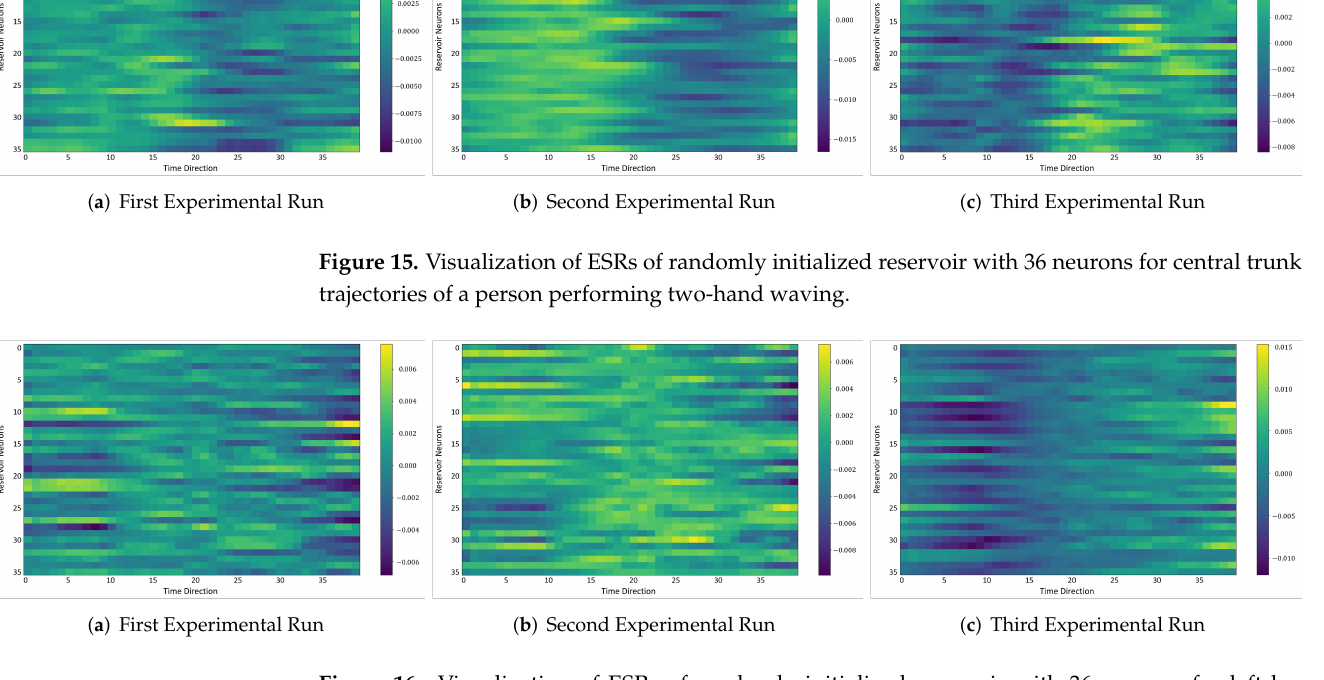
Figure 16. Visualization of ESRs of randomly initialized reservoir with 36 neurons for left leg trajectories of a person performing two-hand waving.